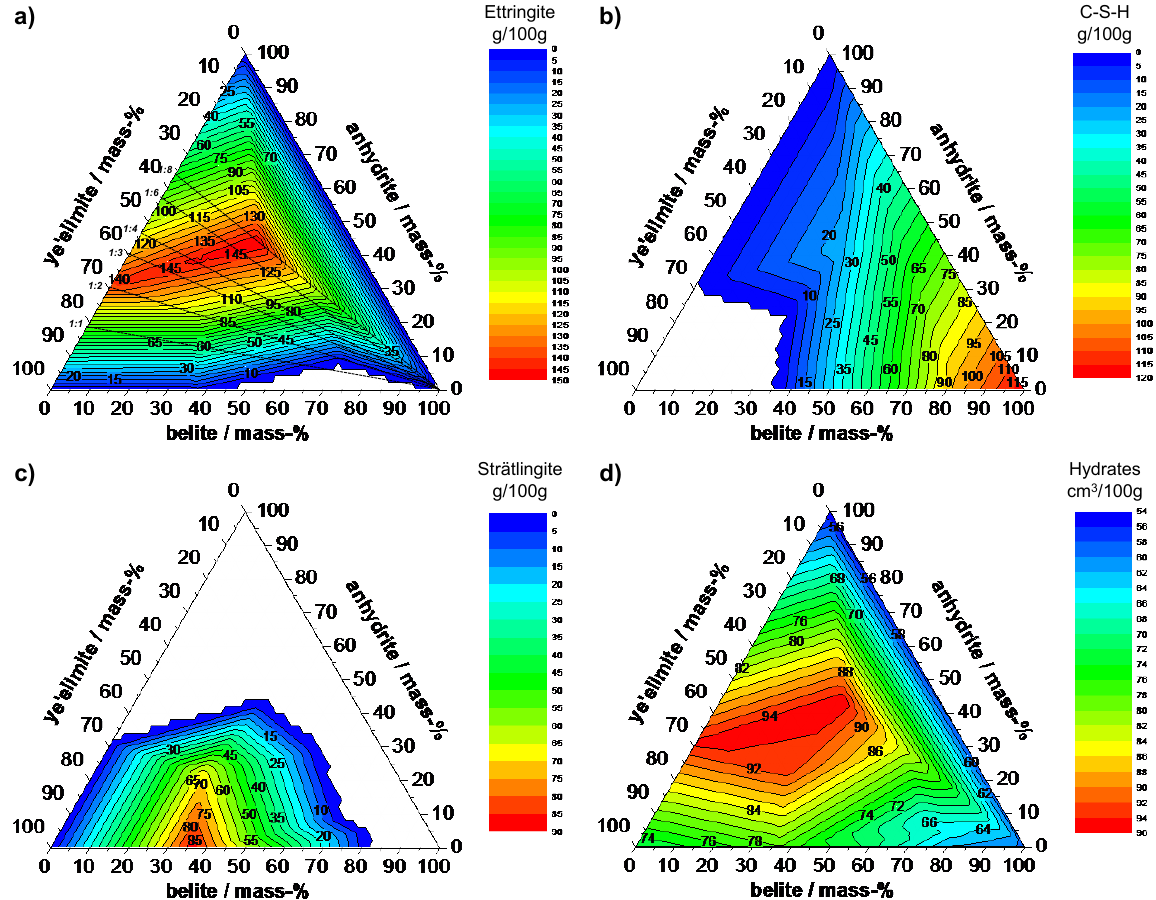
- C 2 S - CS at 20°C. a) ettringite, b) C-S-H, c) strätlingite contents in g per 100 g unhydrated solid, and d) total Figure 2. Ternary diagram C 4 A 3 S volume of hydrates in cm3 per 100 g unhydrated solid. The lines in Figure 2a) represent different molar ratios between ye’elimite � �